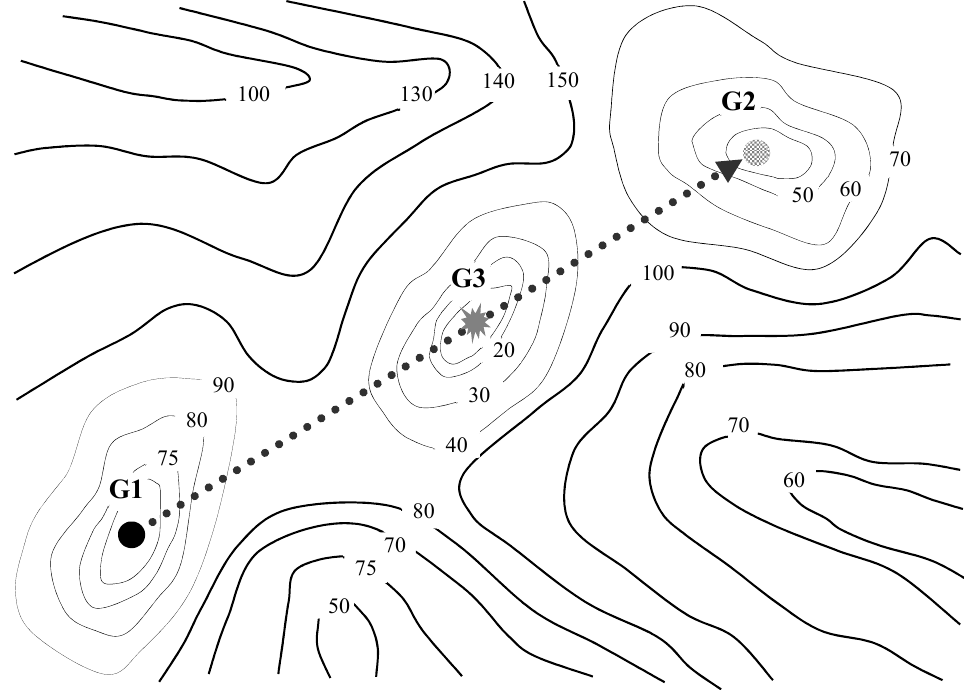
Figure 1. Diagram illustrating how the EPS-PSO algorithm assists the standard PSO in escaping from local optima.